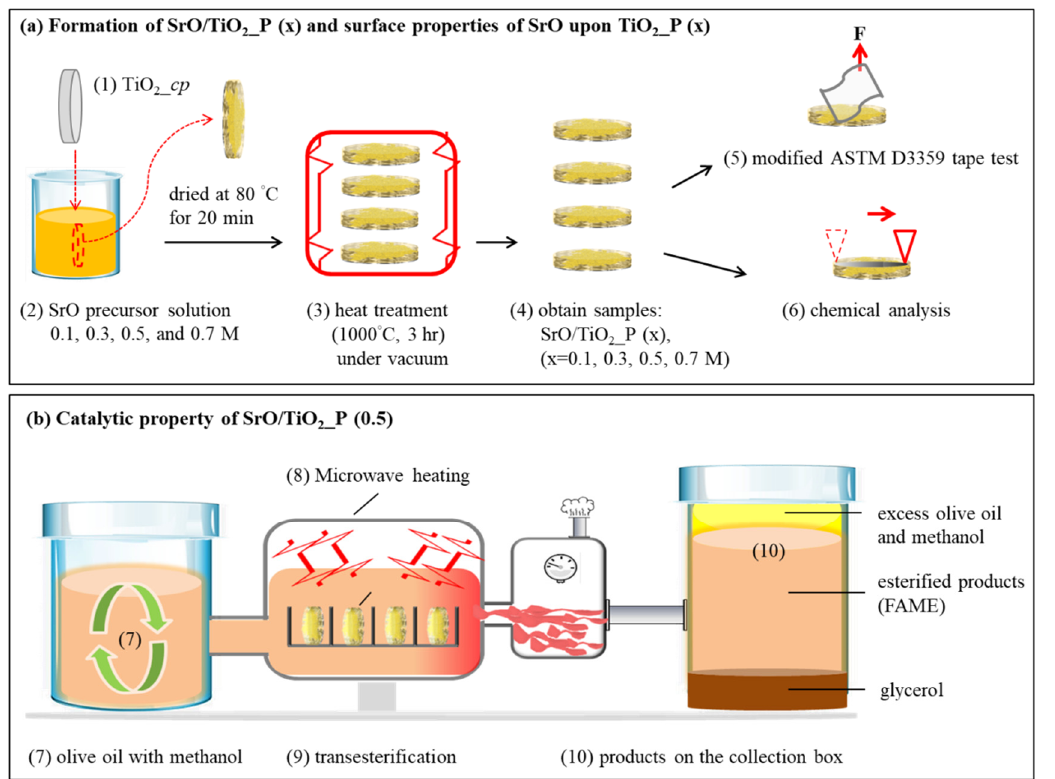
Figure 6. ( a ) The fabrication process and physical strength testing of SrO/TiO 2 _P (x): (1) Pressing of TiO 2 powder into a plate was (TiO 2 _p) (2) then dipping into SrO precursor solution with different concentrations; (3) drying of SrO/TiO 2 _p (x) at 80 °C for 20 min, then 1000 °C for 3 h under vacuum; (4) resulting samples were denoted as SrO_TiO 2 _P (x), (x = 0.1, 0.3, 0.5, or 0.7 M); (5) adhesion strength between SrO 2 and TiO 2 _P, tested through the modified ASTM D3359 tape test; (6) a roughness test was measured by using α step for SrO 2 upon TiO 2 _P; ( b ) the catalytic property of SrO/TiO 2 _P (0.5); (7) ratio of olive oil: methanol was maintained at 1:6; (8) focused microwave-assisted heating system was employed and measured as a function of reaction time; (9) transesterification reaction for biodiesel production; (10) collection of products (esterified products, FAME) and byproducts (glycerol, excess olive oil and methanol) for examination.